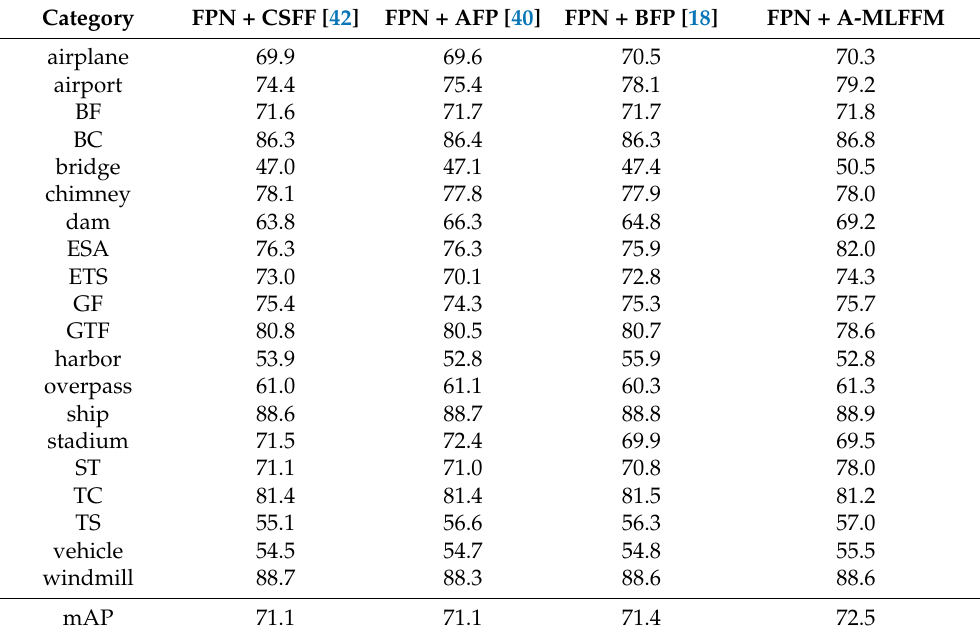
Table 3. Detection accuracy comparisons of FPN with different multi-level feature fusion modules on the DIOR dataset.